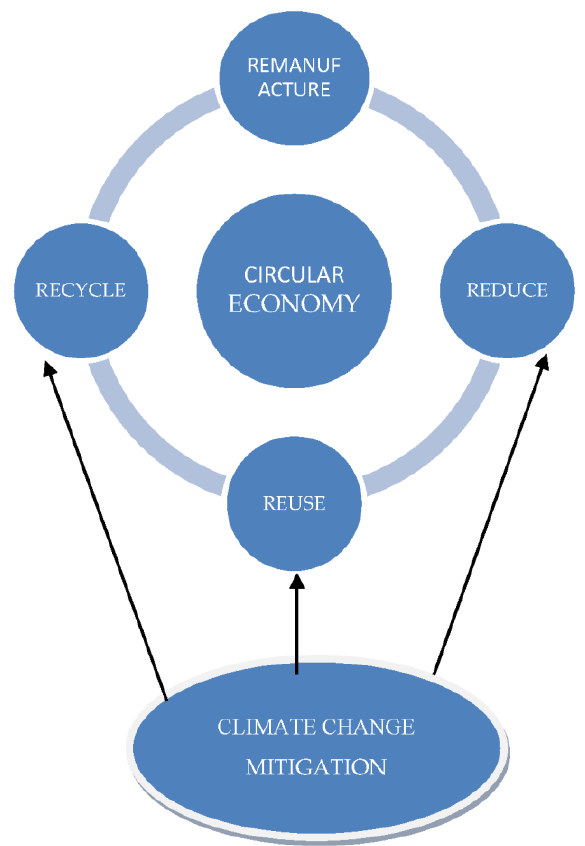
Figure 1. The implications of climate change mitigation on the transition to circular economy. Source Author’s contribution.